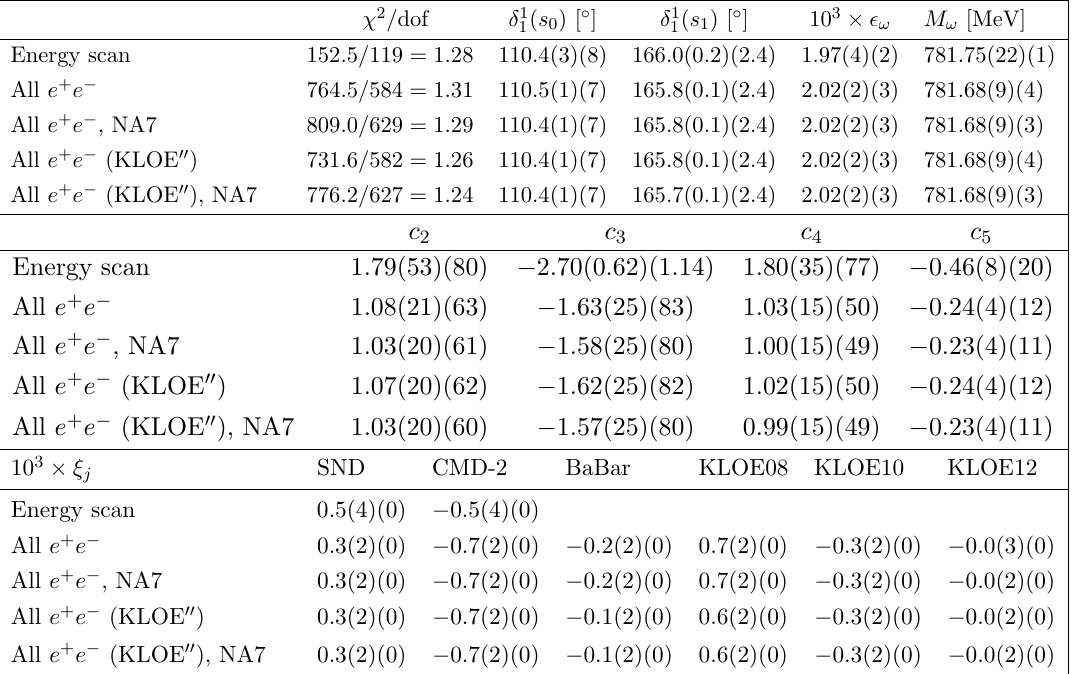
Table 10. Final (cid:12)ts to combinations of data sets with N (cid:0) 1 = 4 free parameters in the conformal polynomial. The (cid:12)rst error is the (cid:12)t uncertainty, in(cid:13)ated by